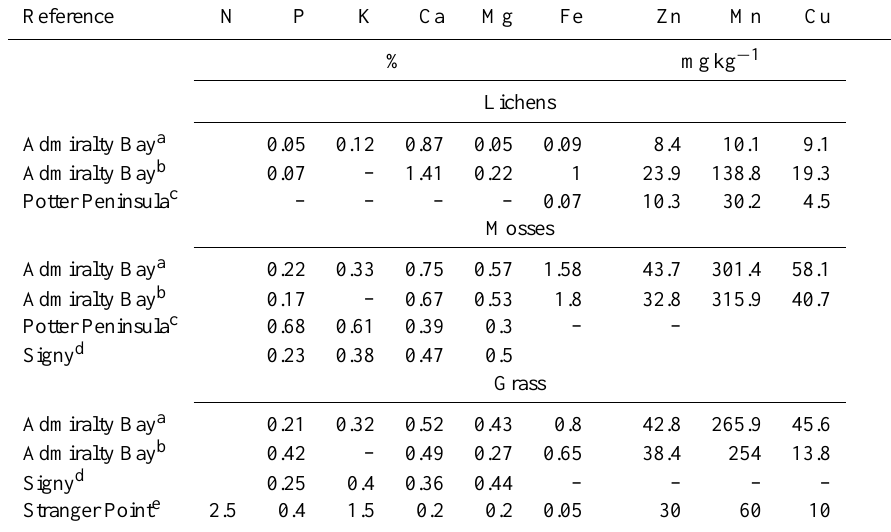
Table 6. Mean values of macro- and micronutrients reported in the literature for maritime